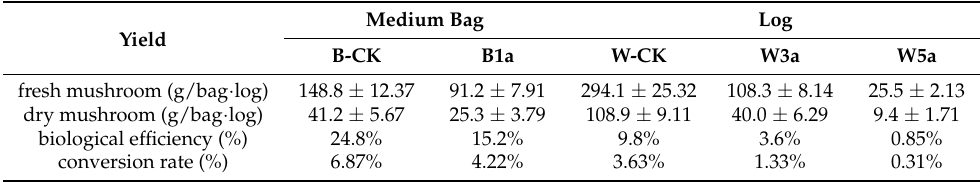
Table 4. Comparison of yield of G. leucocontextum .